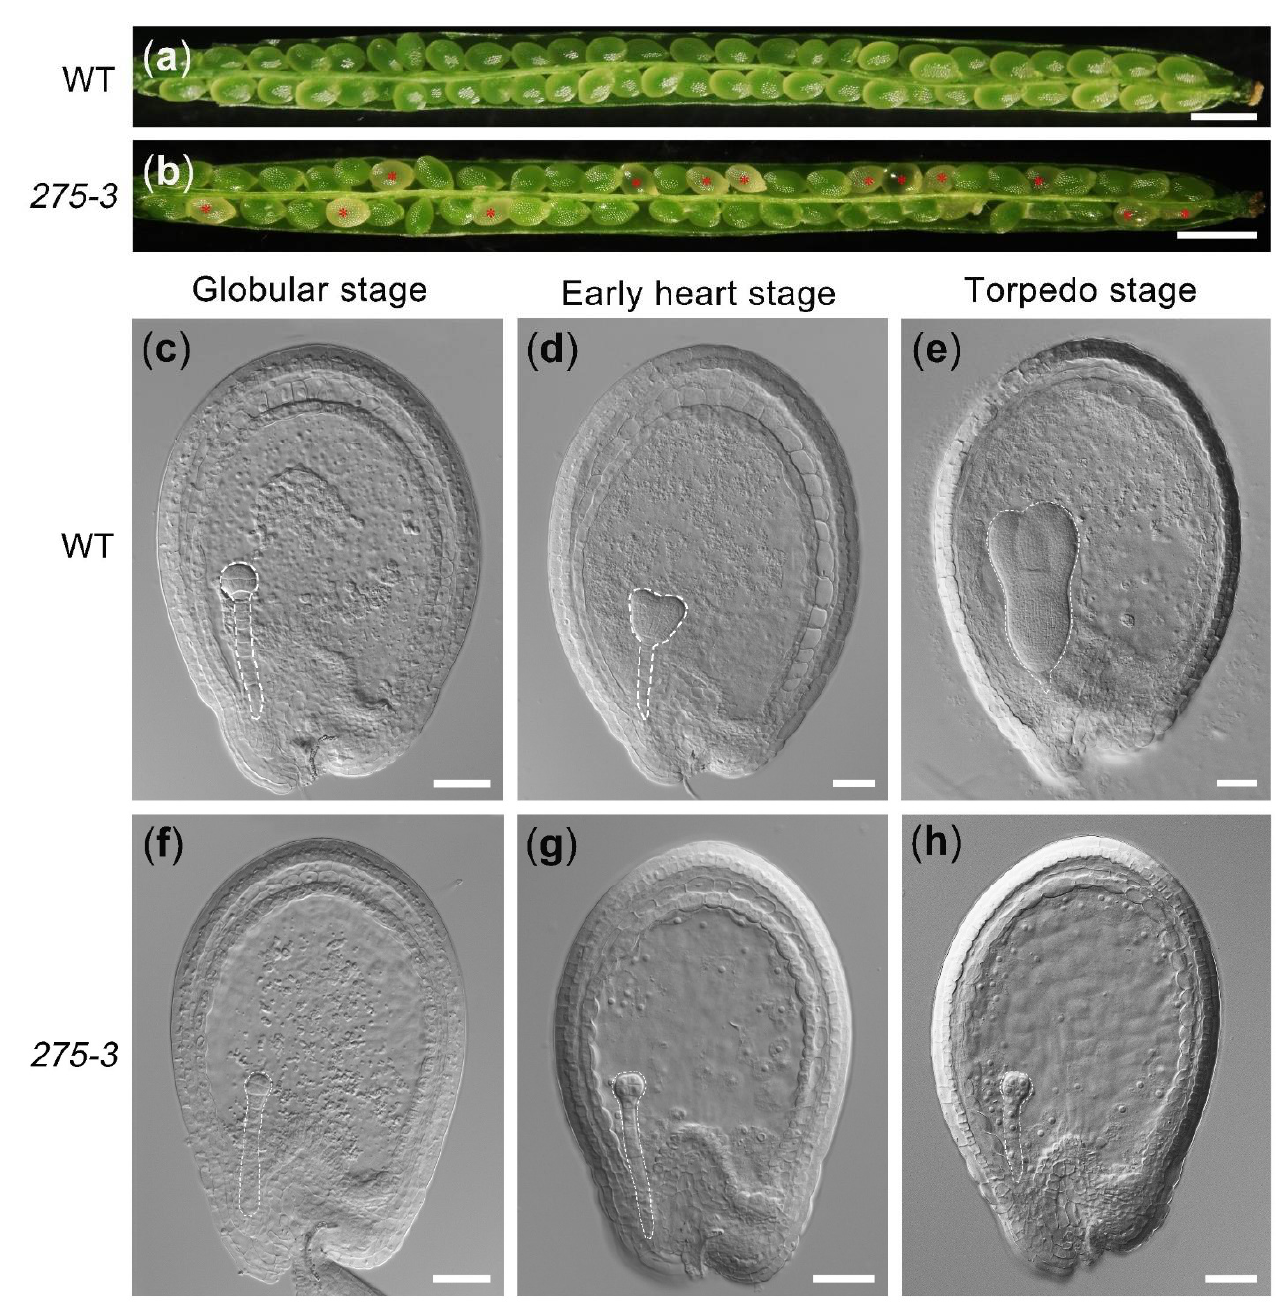
Figure 2. The phenotype of Arabidopsis mutant 275-3 . ( a ) The silique of WT. ( b ) The silique of Arabidopsis mutant 275-3; the red asterisks indicated the albino ovules. ( c – e ) The WT ovules at the globular stage ( c ), early heart stage ( d ) and the torpedo stage ( e ). ( f – h ). The ovules in the mutant 275-3 at which WT ovules were at the globular stage ( f ), early heart stage ( g ) and the torpedo stage ( h ). The bars were 1 mm in ( a ) and ( b ), and 50 µ m in ( c – h ). To clone the mutated gene, firstly, we crossed 275-3 with another ecotype L er (Lands- berg erecta ) to produce F 1 generation. The mutant of the F 1 generation was backcrossed with L er three times to get BC 2 F 1 population and BC 3 F 1 population. In the BC 1 F 1 and BC 2 F 1